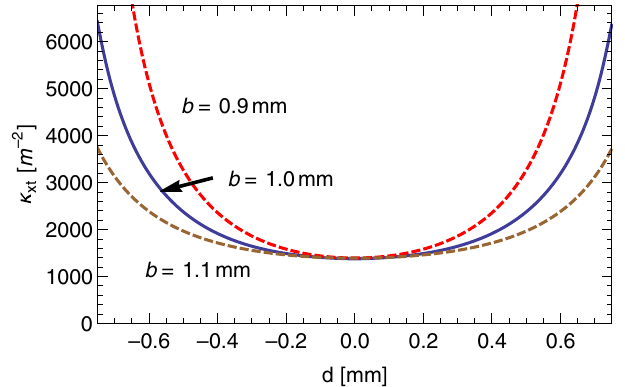
ð b; d Þ as function of tilt FIG. 5. The calculated kick factor ϰ xt parameter d for offset parameter b ¼ 1 . 0 mm (blue solid curve). For comparison, the results for b ¼ 0 . 9 mm (red dashes) and b ¼ 1 . 1 mm (brown dashes) are also shown. To emphasize the difference in curvature of the three curves, the latter two were shifted vertically (by, respectively, − 480 m − 2 , þ 350 m − 2 ) to give the same minimum. The corrugation parameters used were those of the RadiaBeam/SLAC dechirper; the bunch distribution assumed was uniform of full length l ¼ 18 μ m.